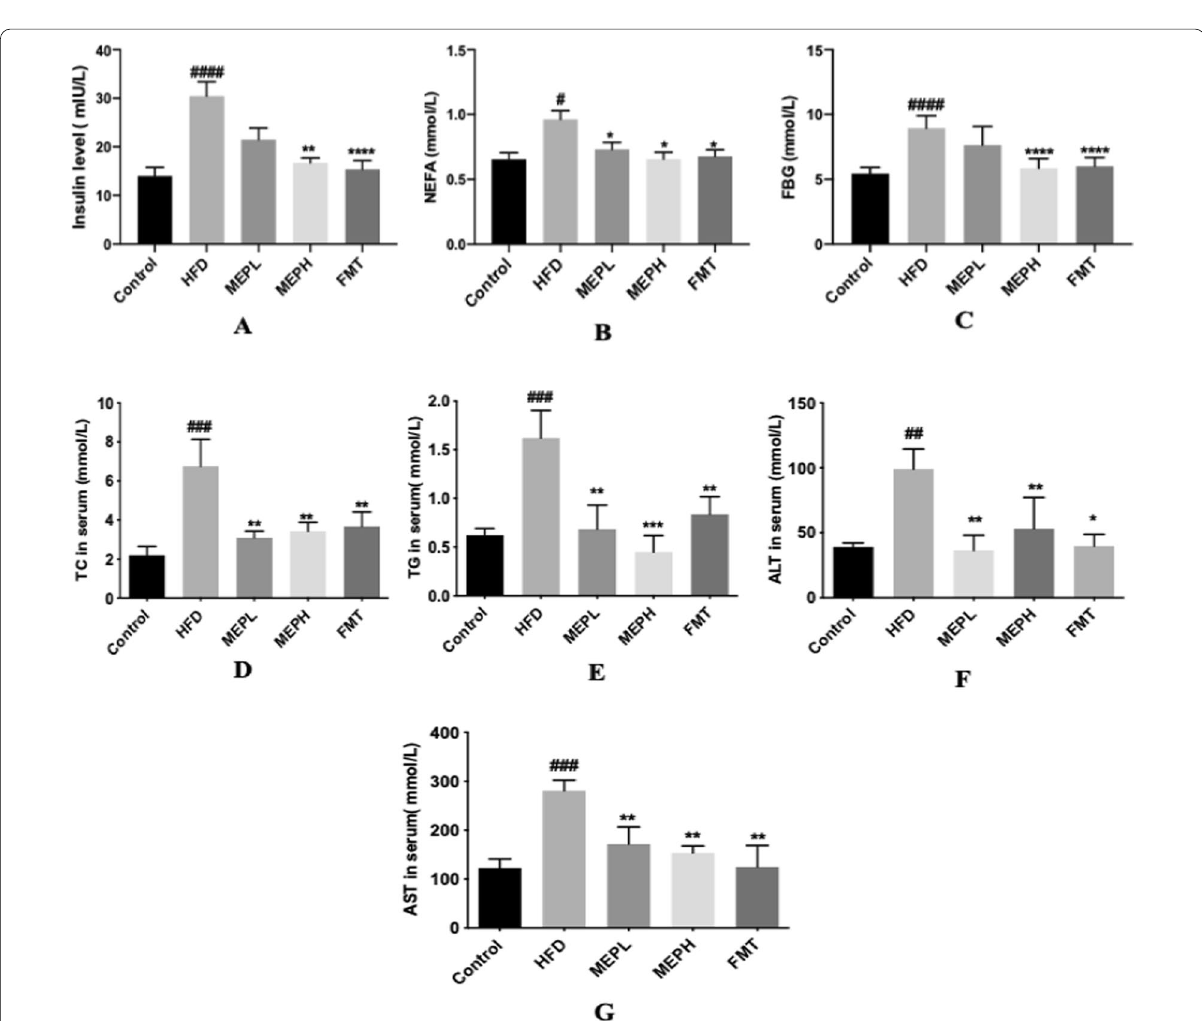
Fig. 4 MEP effect on serum levels of insulin, NEFA, FBG, TC, TG, ALT, and AST in HFD-induced obese mice. A Insulin, B FBG, C NEFA, D TC, E TG, F ALT and G AST. Data are presented as mean SEM (n 8). By using one-way analysis of variance (ANOVA) with Tukey’s multiple comparison, significant ± = differences were presented using # p < 0.05, ## p < 0.01 and ###p < 0.001, #### p < 0.0001 vs. Control group and *p < 0.05, **p < 0.01 and ***p < 0.001 ****p < 0.0001 vs. HFD